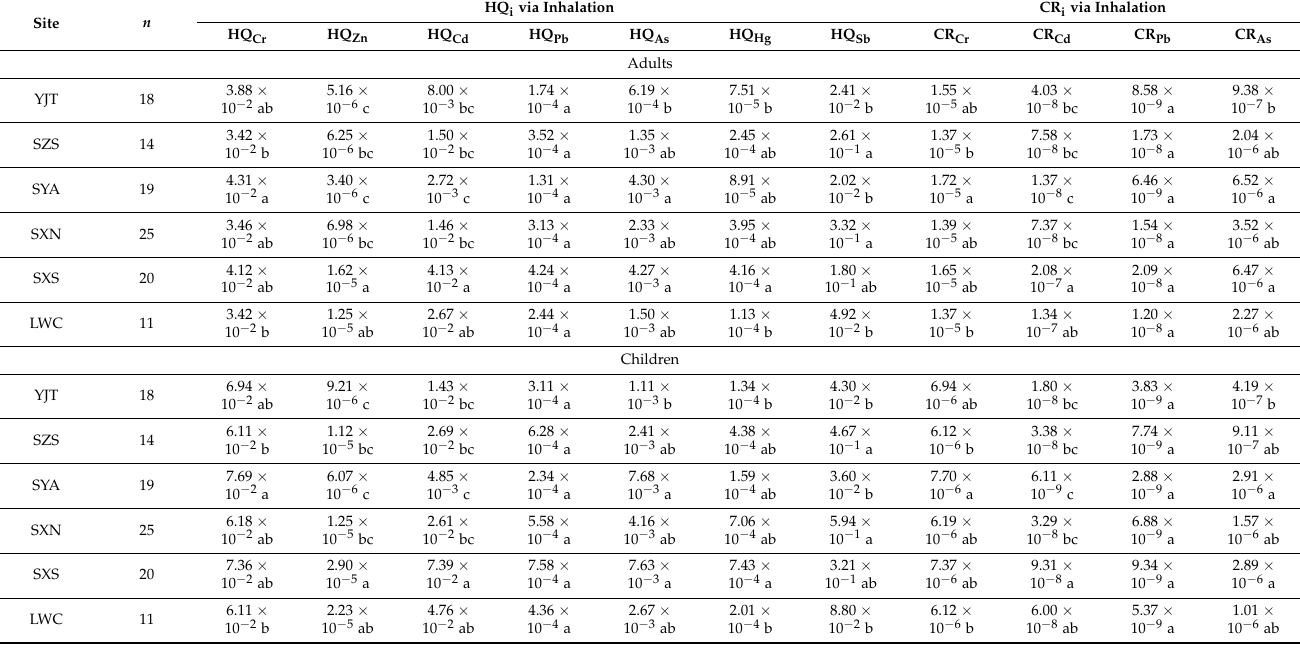
Table 6. Non-carcinogenic hazards (HQ i ) and carcinogenic risk (CR i ) index of PTEs by inhalation.